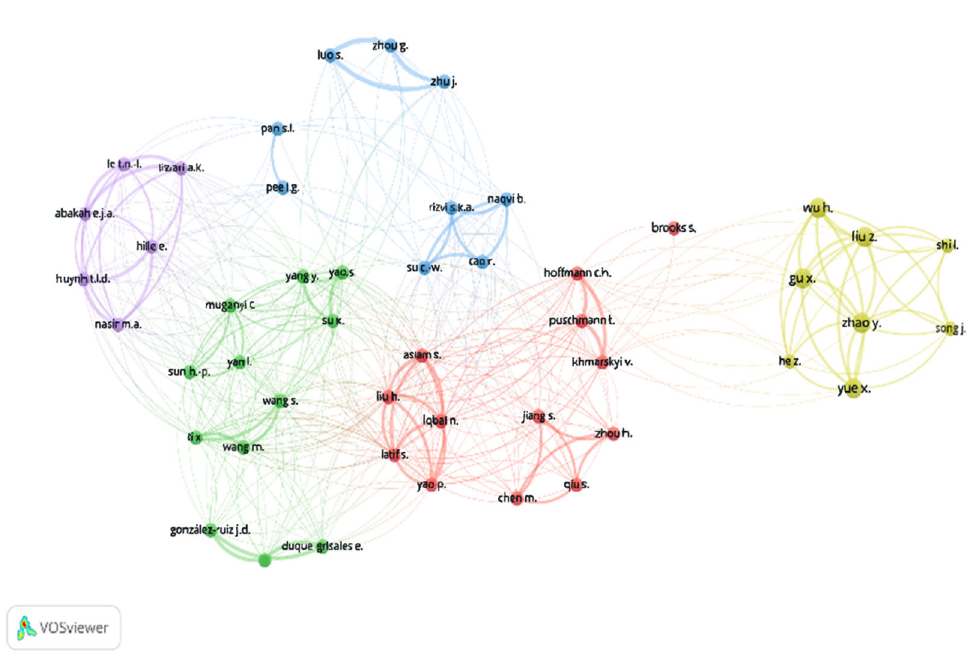
Figure 7. Co ‐ citation analysis of authors using cited author as unit of analysis. Figure 7. Co-citation analysis of authors using cited author as unit of